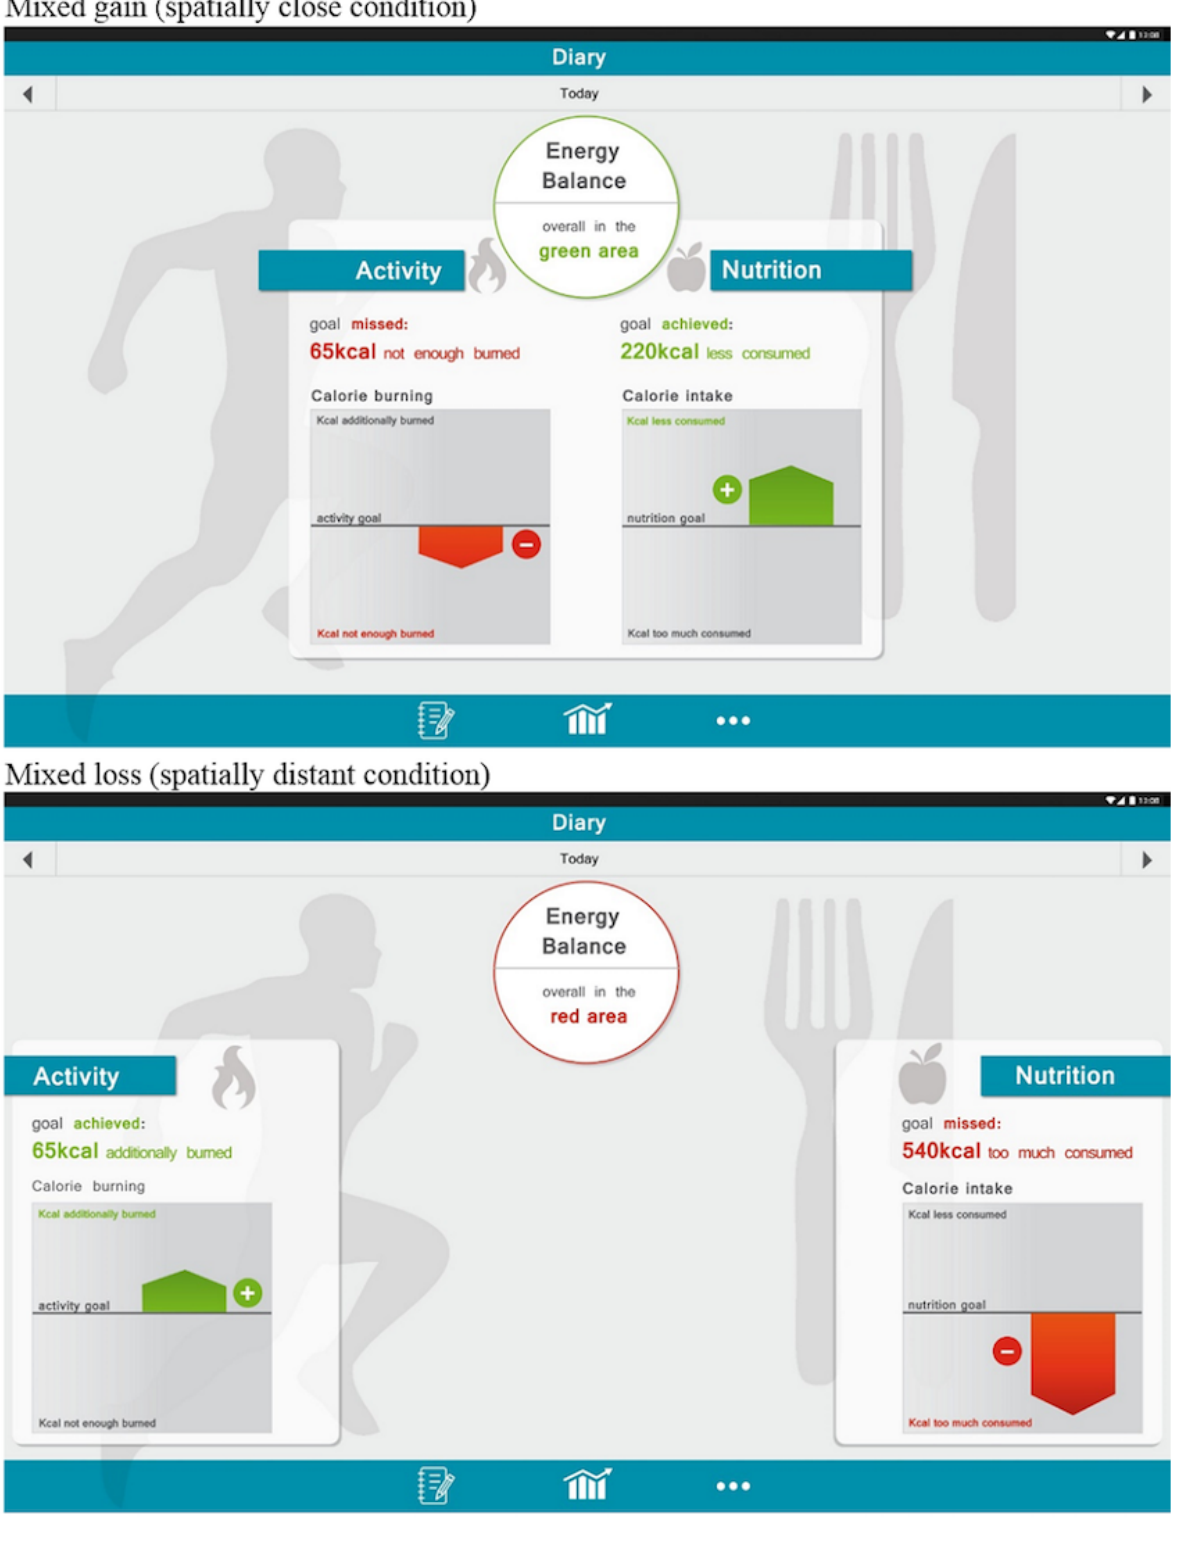
Figure 2. Illustration of mixed-gain and mixed-loss self-tracking